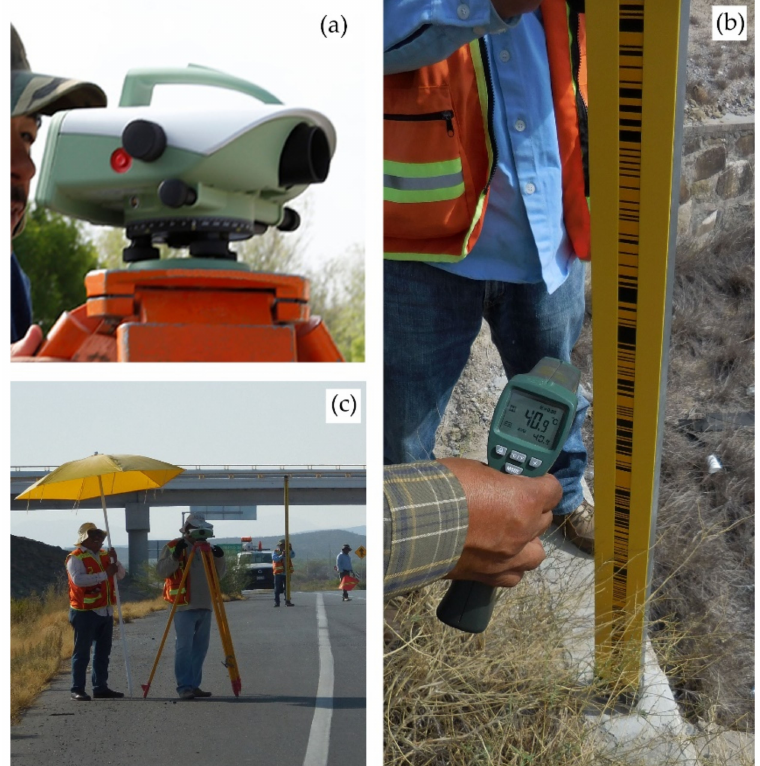
Figure 4. Equipment used by INEGI to perform the geodetic leveling surveys: ( a ) Leica DNA03 automatic digital level, ( b ) level rod with invar bar-code, and ( c ) benchmark leveling.